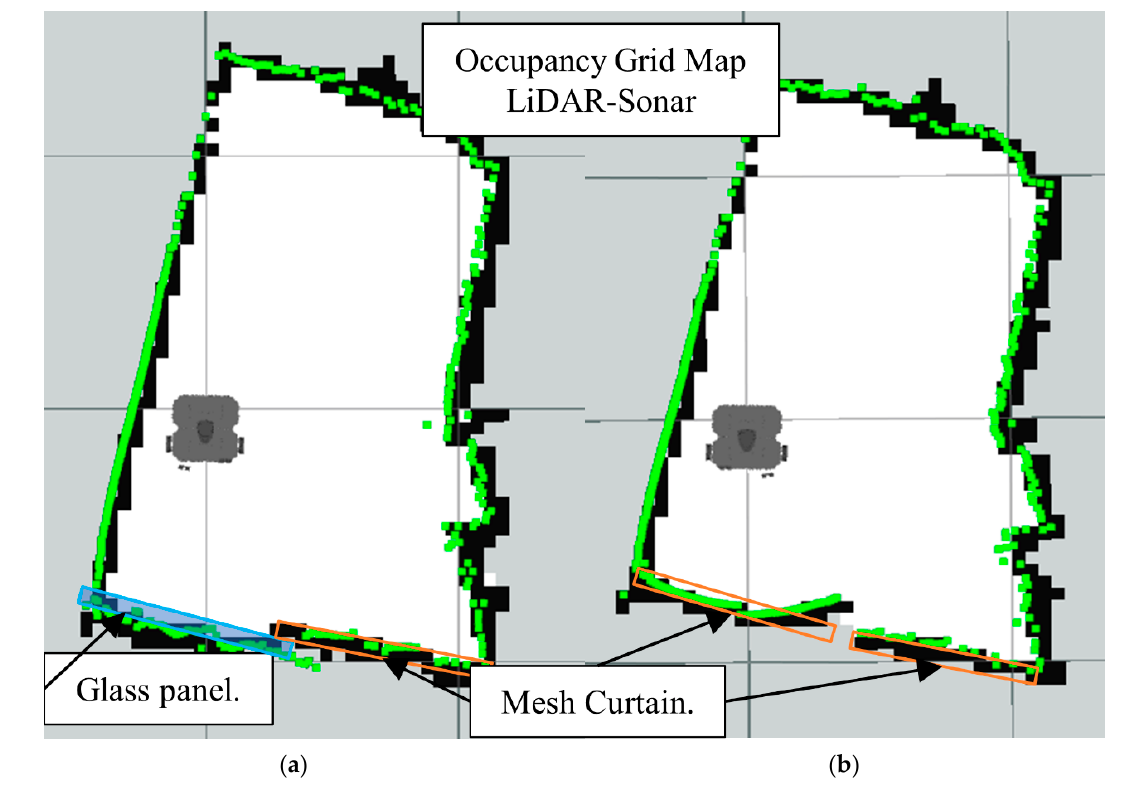
Figure 29. Occupancy grid maps showing the: ( a ) Ground truth (reference map); ( b ) LiDAR-Sonar fusion generated map with dense curtain mesh in front of the glass.